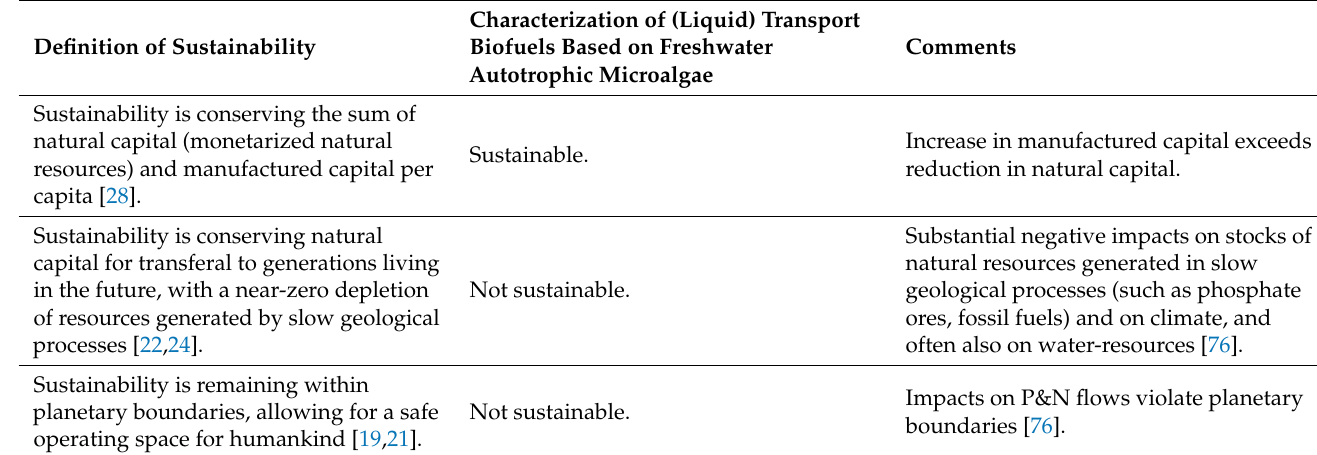
Table 2. The sustainability of (liquid) transport biofuels based on freshwater autotrophic microalgae using three definitions of sustainability.